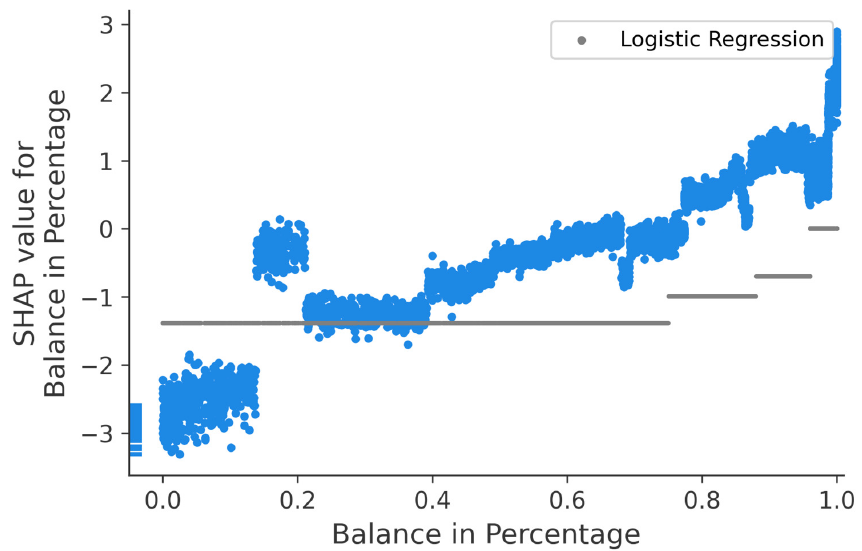
Figure 10. SHAP dependence plot showing SHAP values for balance in Percentage . Logistic Regression feature effects for the balance are displayed in grey and scaled to log-odds, corresponding to the SHAP values on the y -axis. All values from the four separate Balance in Percentage bins are mapped back to original values to fit the x -axis.